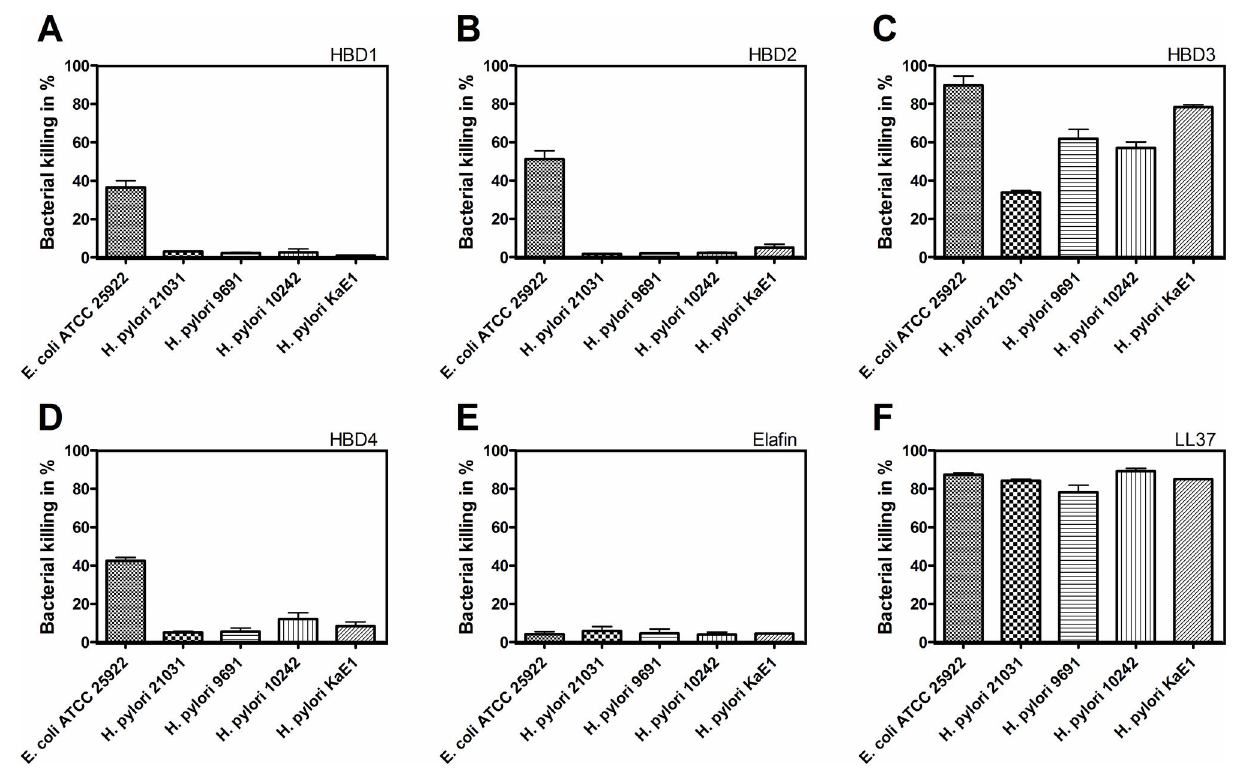
Figure 5. Sensitivity of various H. pylori strains to HBD1-4, elafin and LL37. The antibacterial activity of HBD1-4, elafin and LL37 was tested by flow cytometry. Cell damage or cell death lead to the uptake of the green fluorescent dye DiBAC killed by 20 µg/ml of all recombinant antimicrobials tested. In contrast, H. pylori was affected only by HBD3 (C) and LL37 (F) and not by HBD1 (A), HBD2 (B), HBD4 (D) and elafin